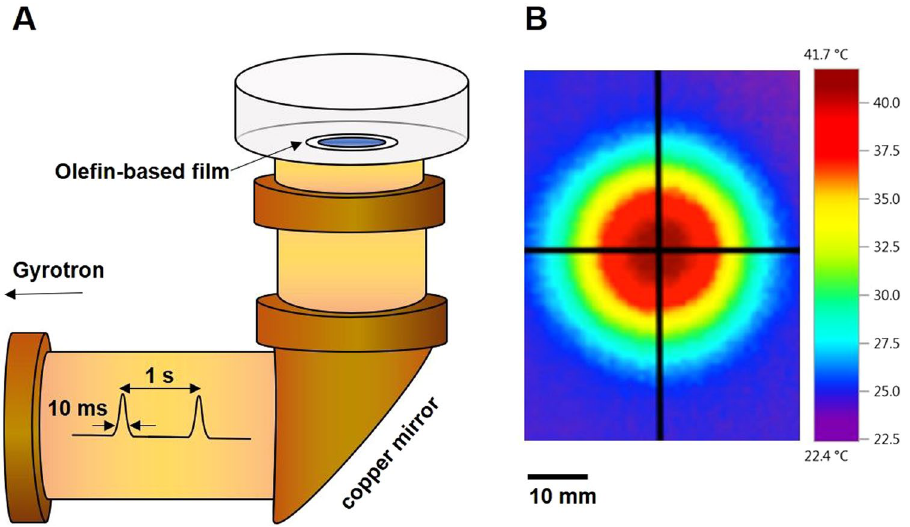
Figure 1. Schematic representation of experimental conditions. ( A ) Irradiation with THz waves generated by a Gyrotron in the pyrene actin solution. The solution was placed on an olefin-based film over the waveguide and subjected to irradiation at 25 °C. ( B ) The beam profile of the THz wave output measured by